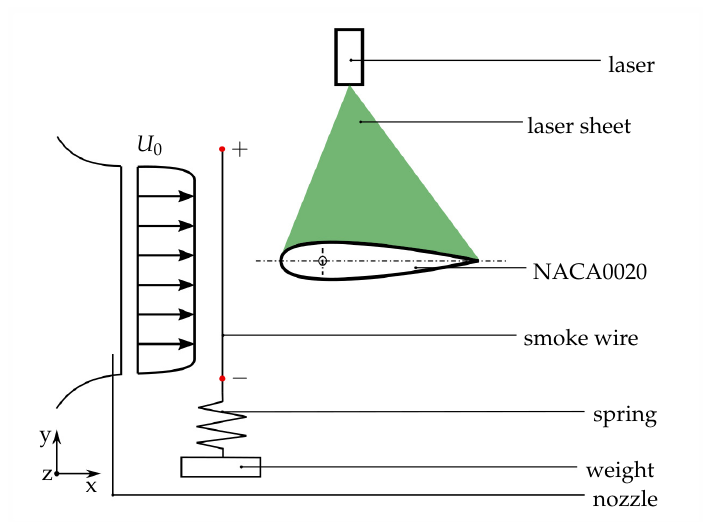
Figure 8. Illustration of the experimental setup for the smoke–wire visualization; side view of the experimental